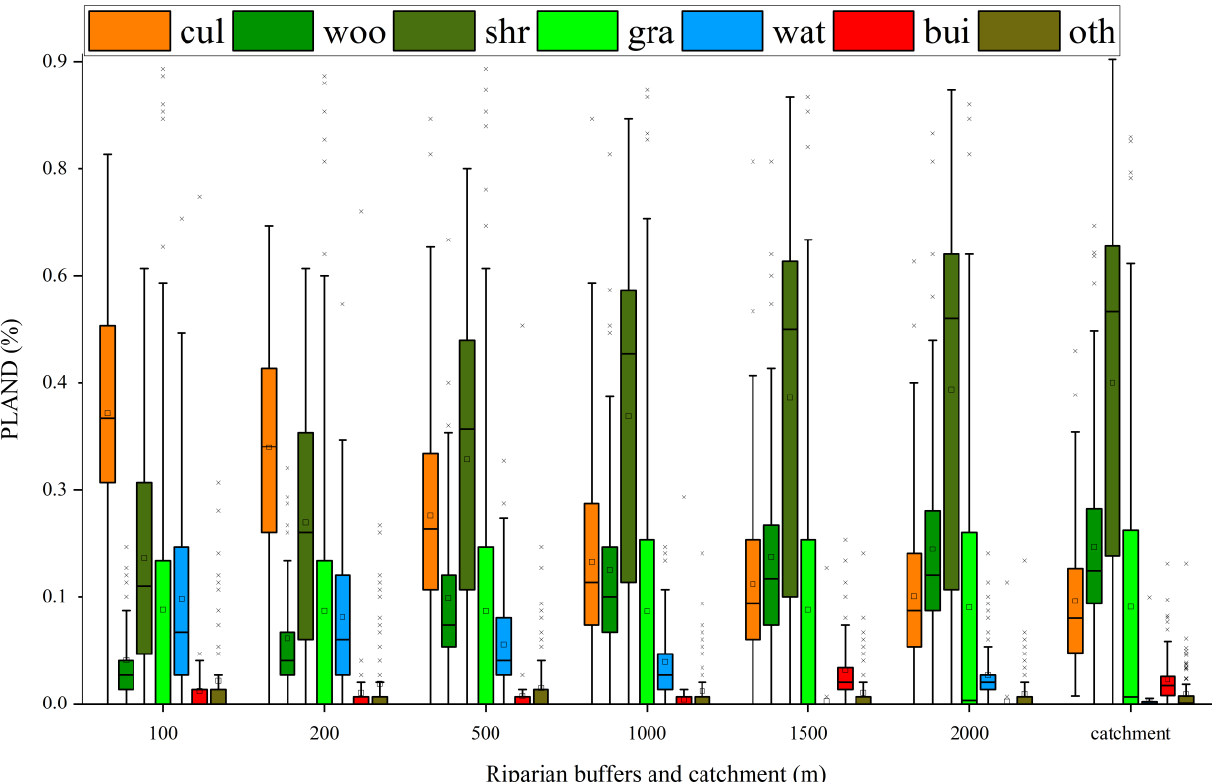
Figure 2. The variations in the land use composition of the riparian buffer widths and catchment. Land use types include the cultivated land (cul), woodland (woo), shrubland (shr), grassland (gra), water bodies (wat), built-up land (bui) and other land (oth).